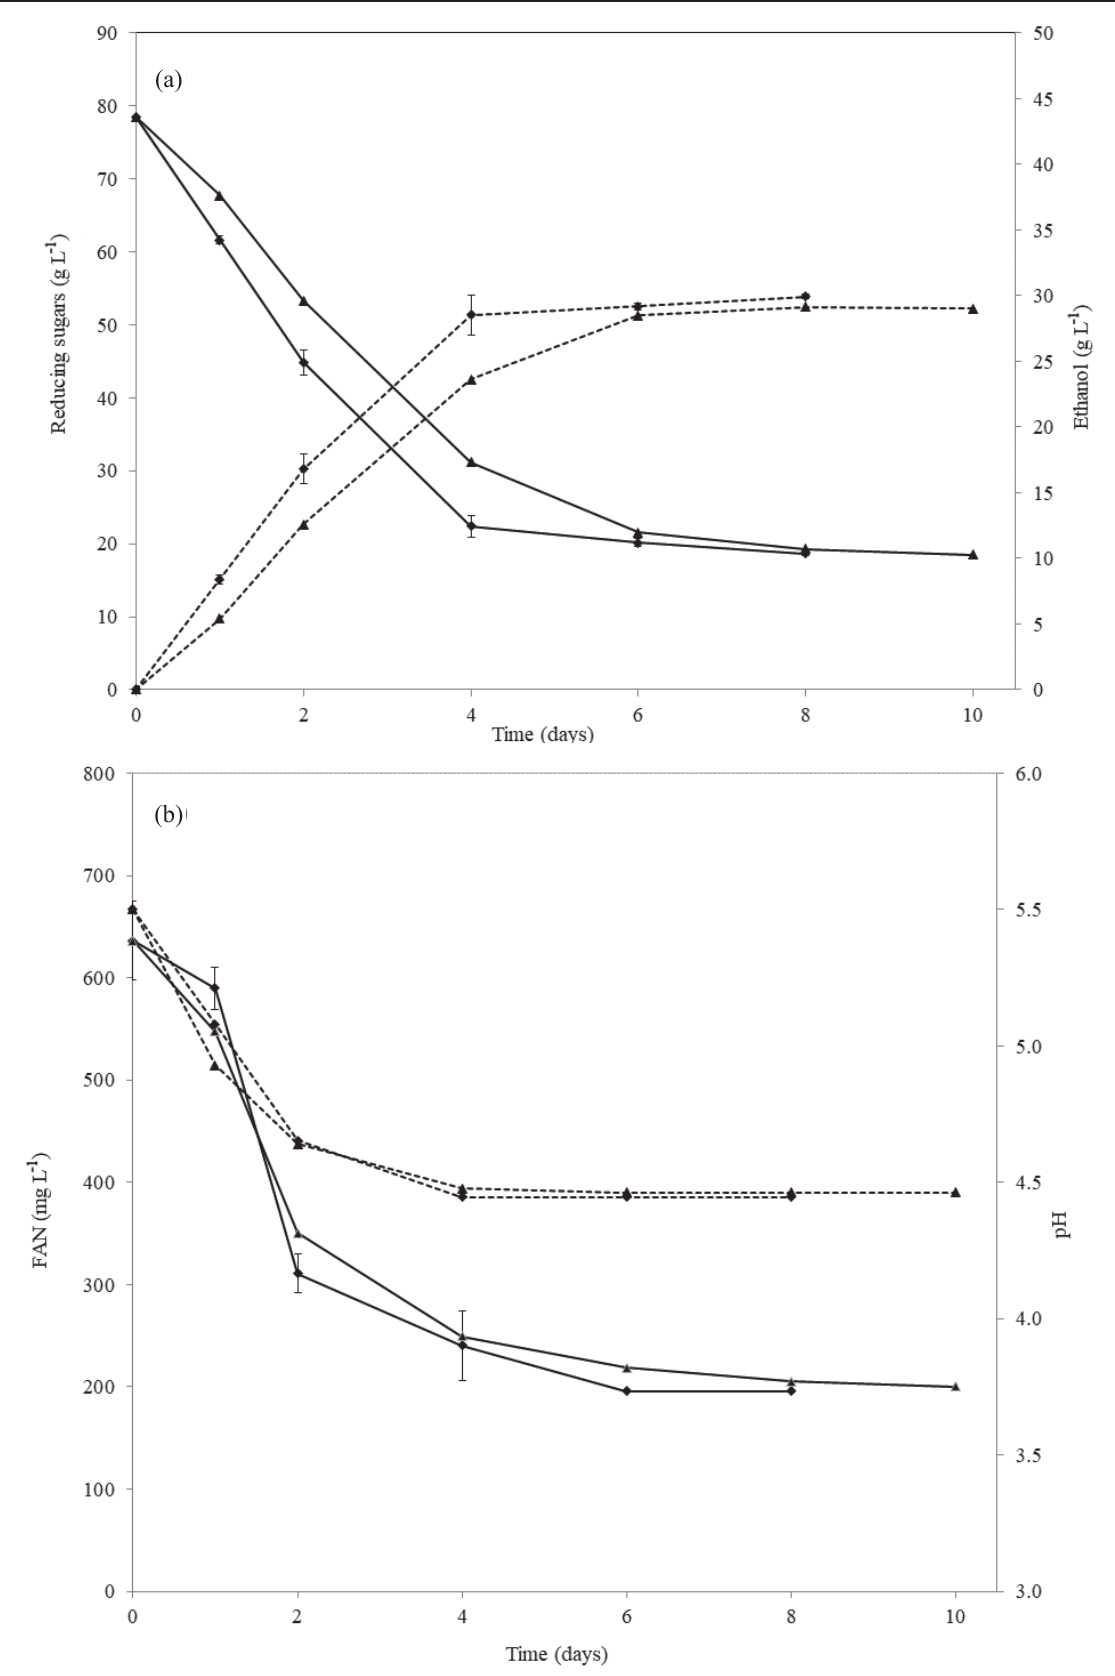
Fig. 4 – Fermentation kinetics carried out with free (▲) and immobilized cells (♦) cultivated in 14°Brix laboratory malt wort at 15 °C. Continuous lines (reducing sugars and FAN), dotted lines (ethanol and pH). Reducing sugar consumption and eth­ anol production (a), FAN consumption and pH variation